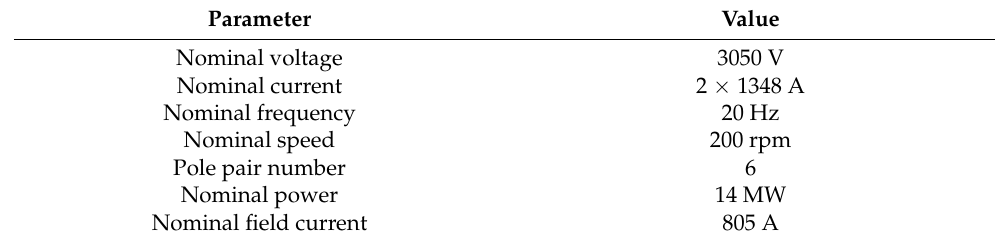
Table 1. Nominal data of the used EESM with double stator windings.